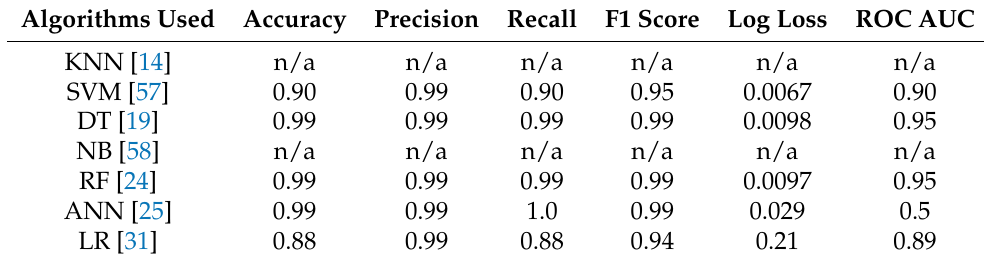
Table 33. DoS HTTP weighted classes